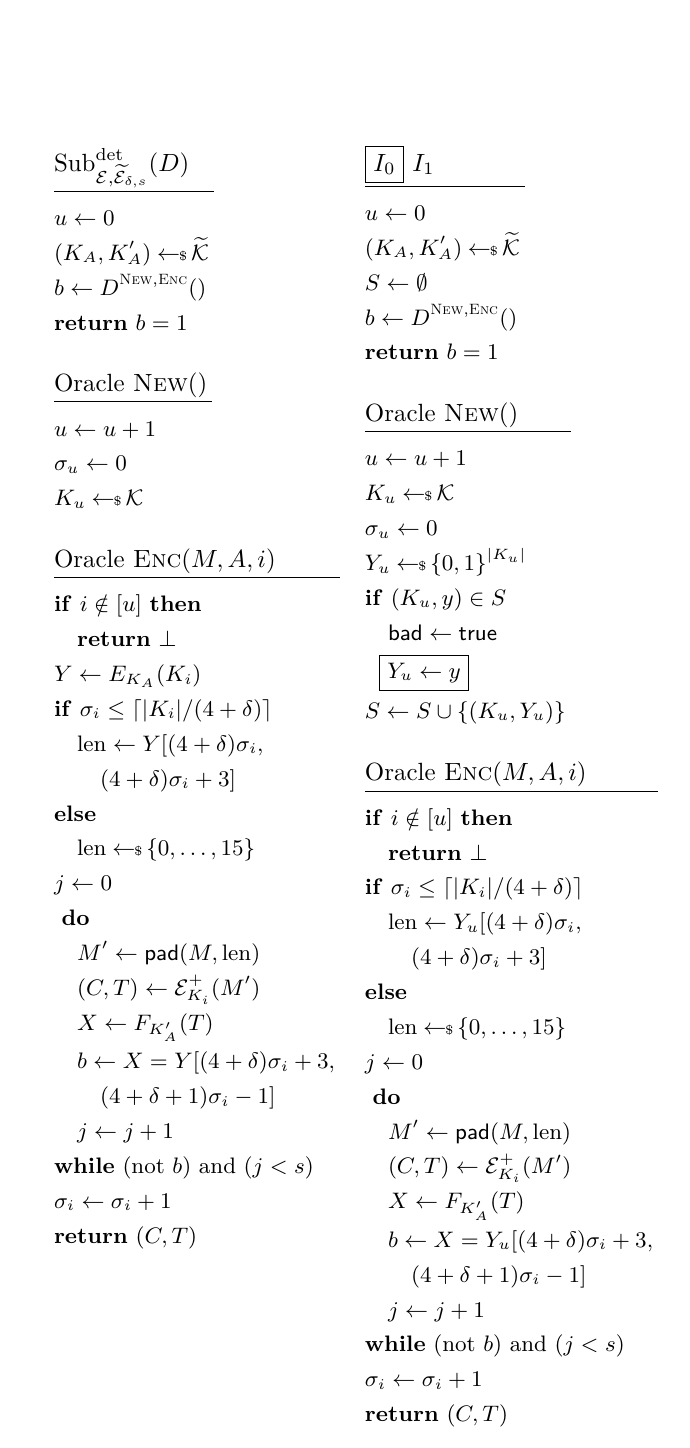
Figure 5.1: Games Sub det ( D ), I 0 , and I 1 used in the proof from Section E , e E δ,s